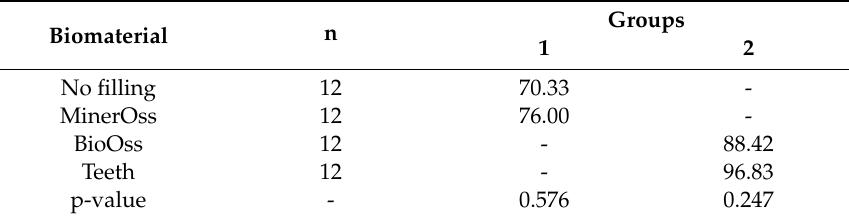
Table 4. Tukey HSD test. The means of percentages di ff erences for the groups in homogeneous subsets are